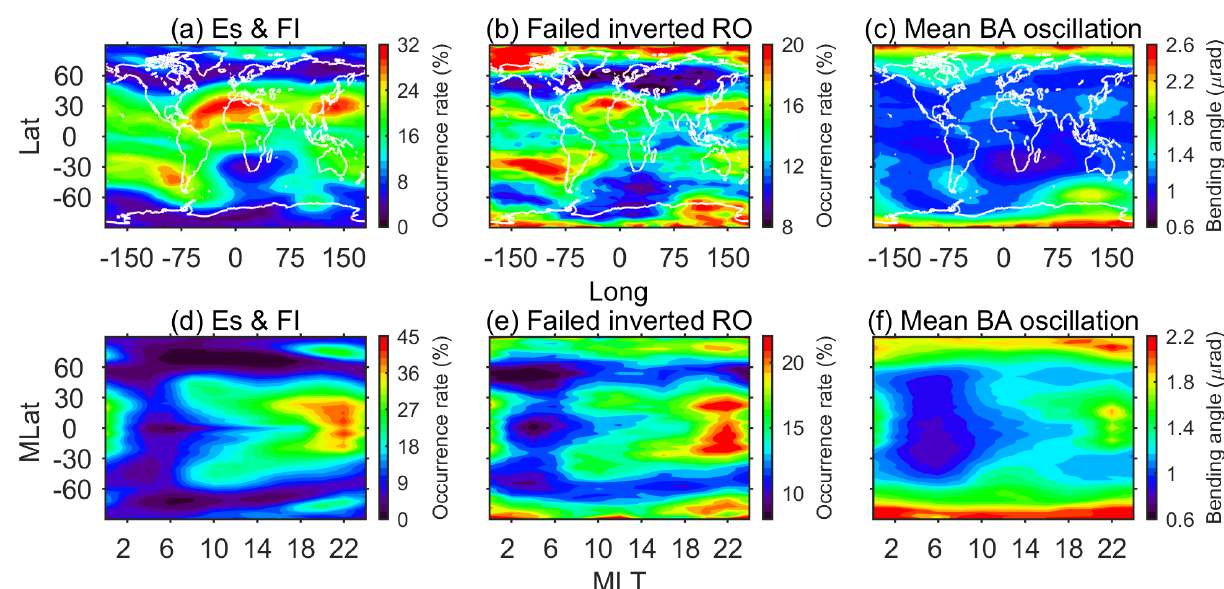
Figure 3. Global geographical (a–c) and geomagnetic distributions (d–f) of the E s and F layer irregularity occurrence rate (a, d) , the failed inverted RO event occurrence rate (b, e) , and the mean bending angle oscillation (c, f) during 2011–2013.